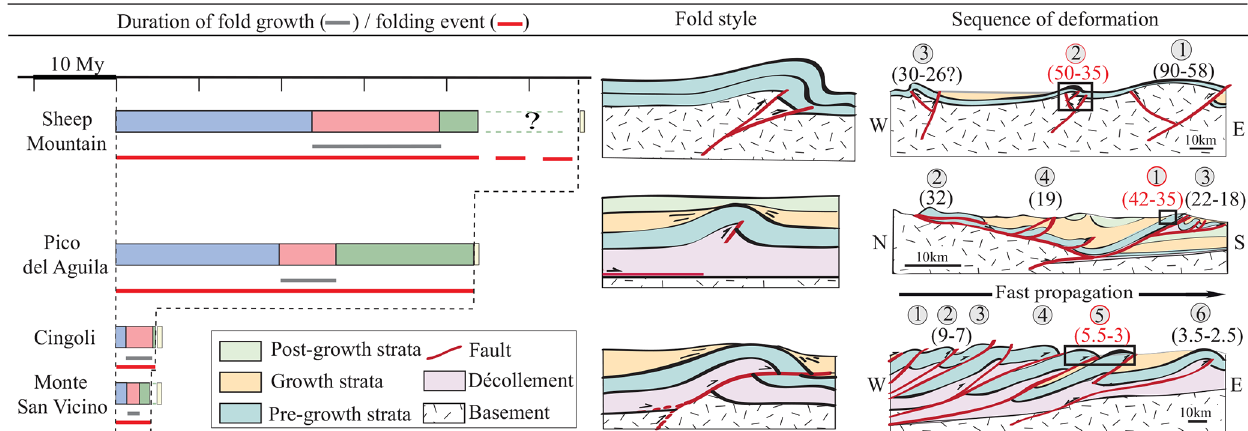
Figure 7. Compared durations of the deformation stages of the folding event, fold style (i.e. final fold geometry) and sequence of regional deformation for the four studied folds (circled numbers 1 to 6: order of structural development, i.e. sequence of folding/thrusting, with corresponding ages in Ma (in parentheses)); red: from this study; black: from the literature (Beaudoin et al., 2018, for Wyoming, Jolivet et al., 2007, for the Pyrenees, Calamita et al., 1994, and Curzi et al., 2020, for the Apennines). Colour code: blue – layer-parallel shortening (LPS); red – fold growth; green – late-stage fold tightening (LSFT); yellow – post-folding